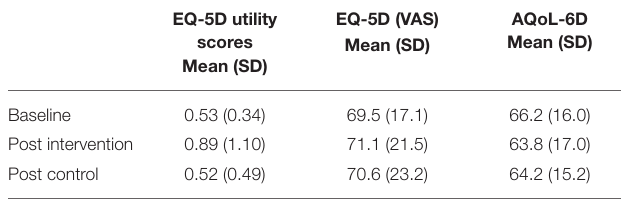
TABLE 7 | Quality of life scores.